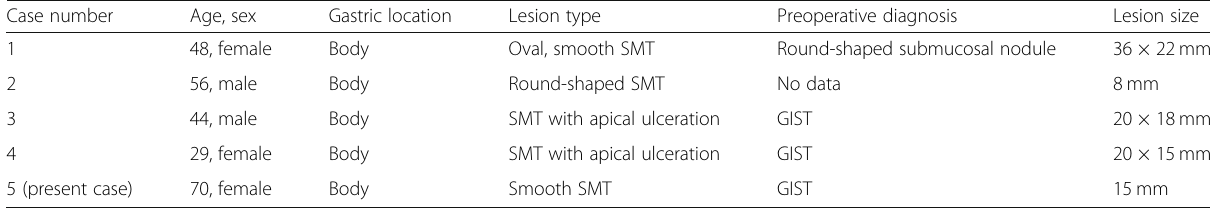
Table 1 Cases of IgG4-RD presenting as a gastric